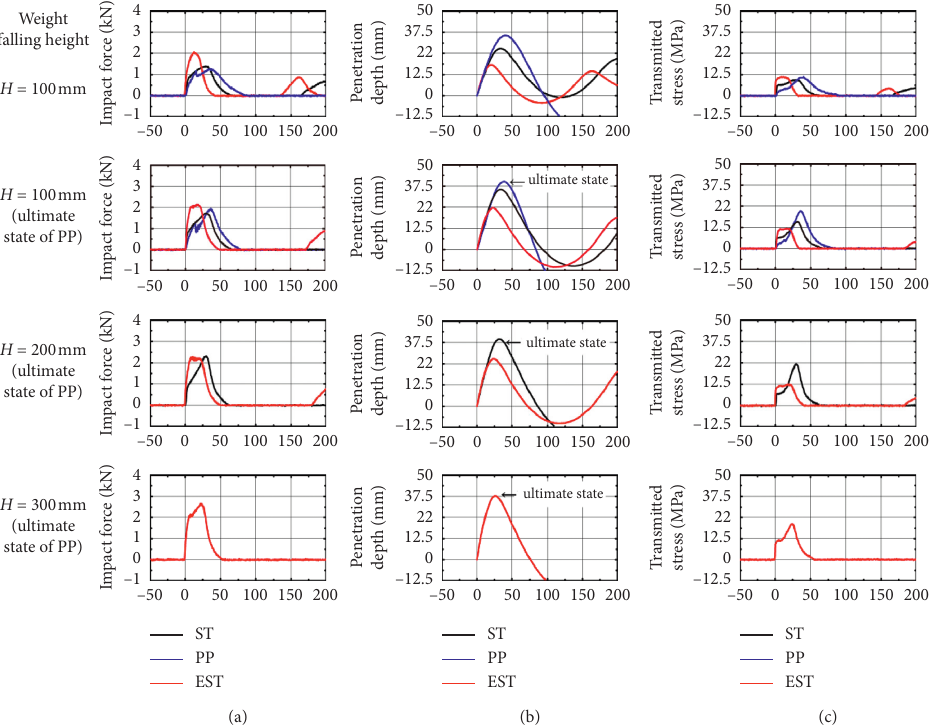
Figure 7: Various time history response waveforms in the case of material without a core slab. (a) Impact force. (b) Weight penetration depth. (c) Transmitted impact